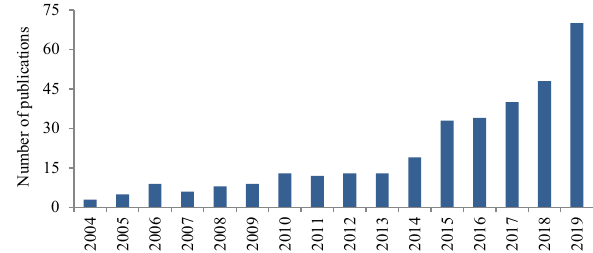
Figure 1 The number of publications with the words “biofilm dairy” in PubMed by year (https://www.ncbi.nlm.nih.gov/ pubmed/?term=biofilm+dairy; Date of the